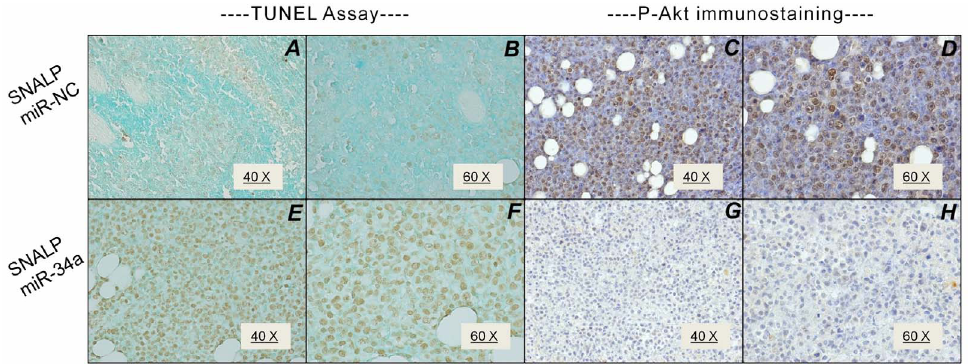
Figure 6. SNALP miR-34a reduces Akt activation and induces apoptosis in MM invivo . TUNEL assay of SKMM-1 xenograft retrieved from SNALP miR-NC (A, B) and SNALP miR-34a (E, F) treated mice. The TUNEL positive cells are colored in brown. Representative image at 40-fold (A, E) and 60-fold (B, F) magnification are shown. p-Akt immunostaining SKMM-1 xenograft retrieved from SNALP miR-NC (C, D) and SNALP miR-34a (G, H) treated mice. Representative image at 40-fold (C, G) and 60-fold (D, H) magnification are